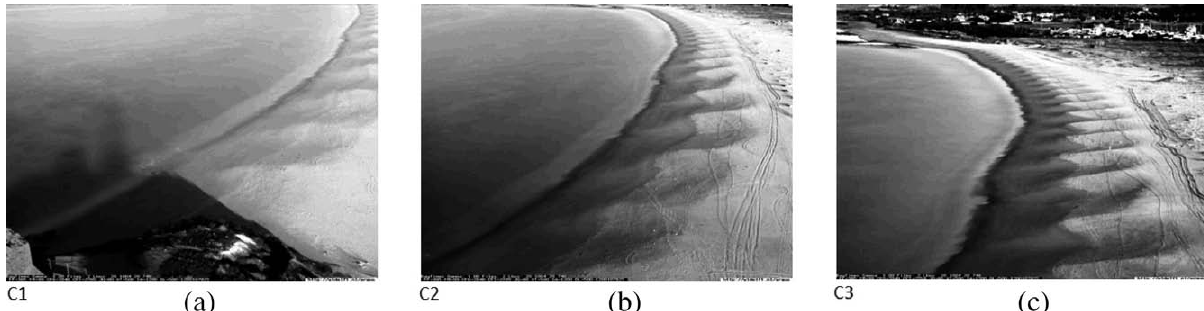
Fig . 2. – Examples of timex images from (a) camera 1 showing the part of the beach closest to Trafalgar Cape; (b) camera 2 looking to the middle of the beach, and (c) camera 3 visualizing the northern part of the beach. 26 January 2005.